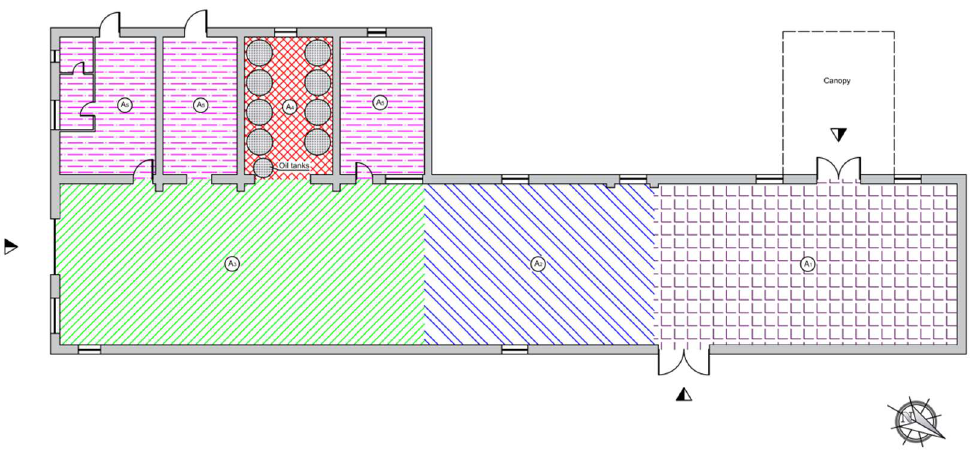
Figure 4. Lay-out floor plan of the Olive Oil Mill. A 1 : area for the delivery of raw material; A 2 : pre-processing area; A 3 : processing area; A 4 : oil storage area; A 5 : service area.